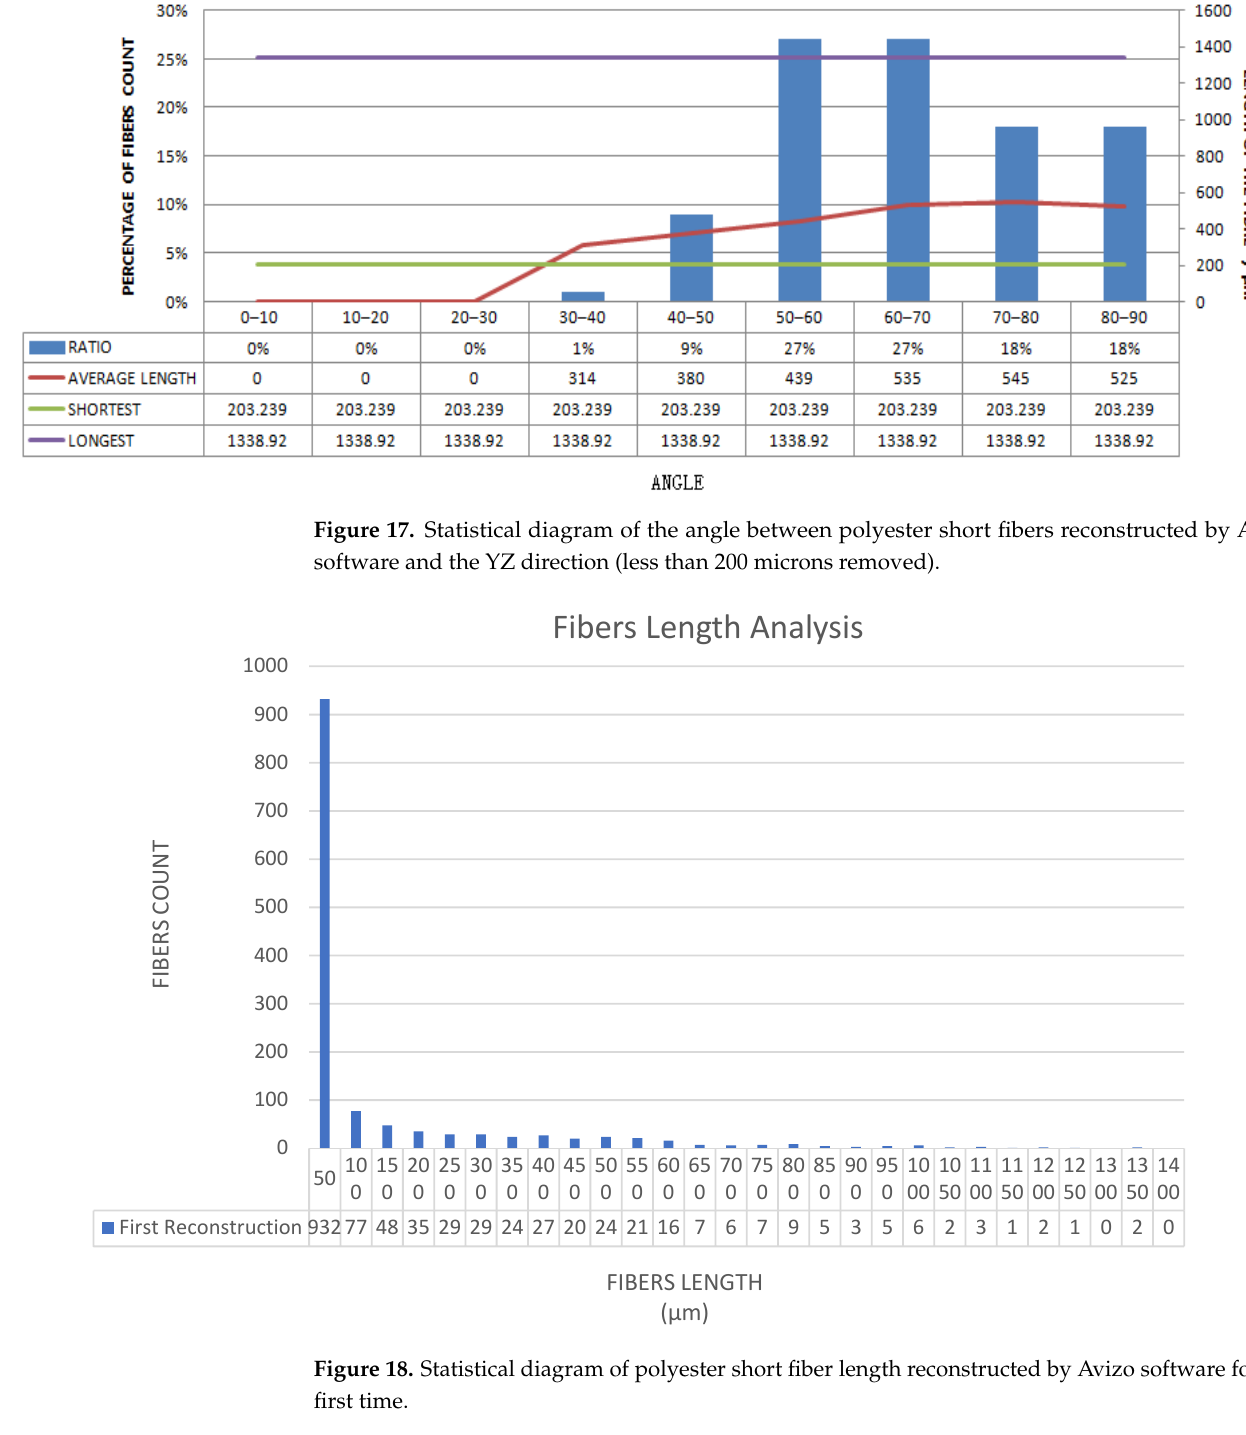
Figure 18. Statistical diagram of polyester short fiber length reconstructed by Avizo software for the first time.